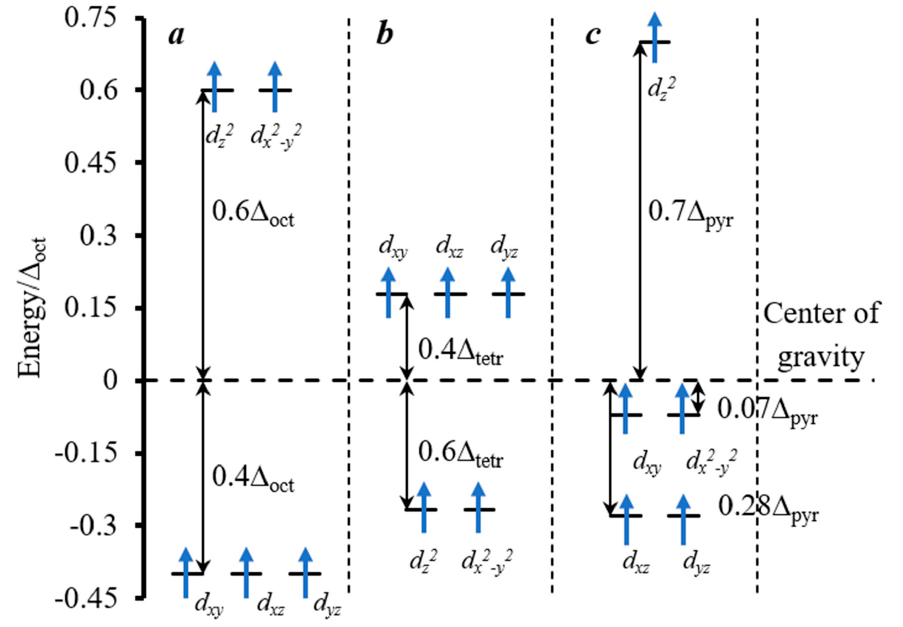
Figure 2. The splitting of the d-sublevel in ( a ) the octahedral, ( b ) tetrahedral, and ( c ) the trigonal-bipyramidal field of the ligands and its population by the electrons for Fe 3 + (d 5 ) in the weak ligand field.